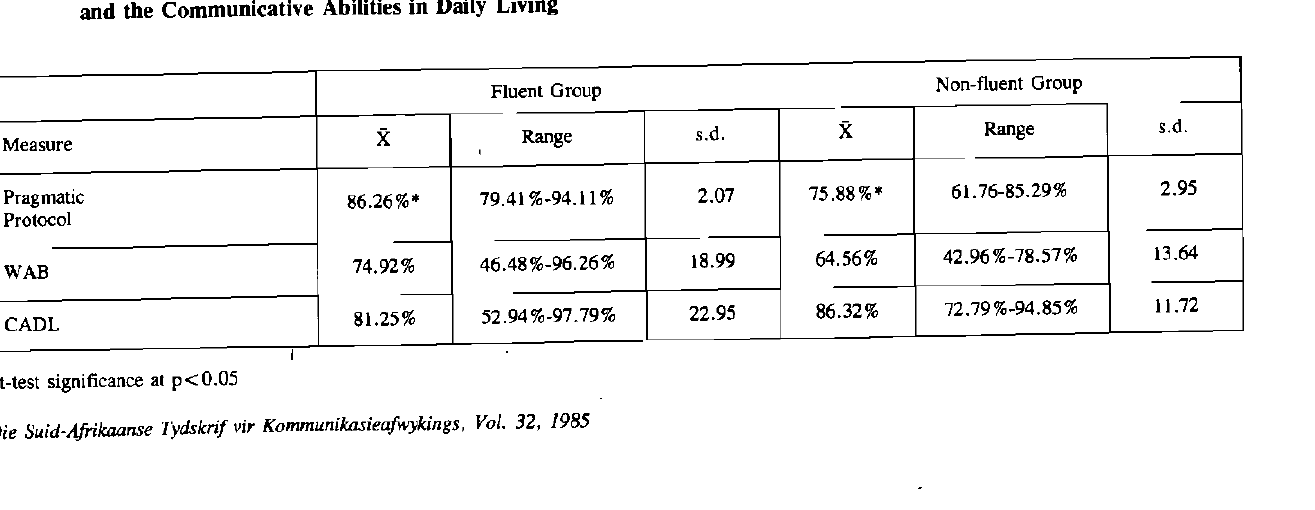
Table 5 Percentage group means, ranges and standard deviations «η the Pragmatic Protocol, the Western Aphasia Battery and the Communicative Abilities in Daily